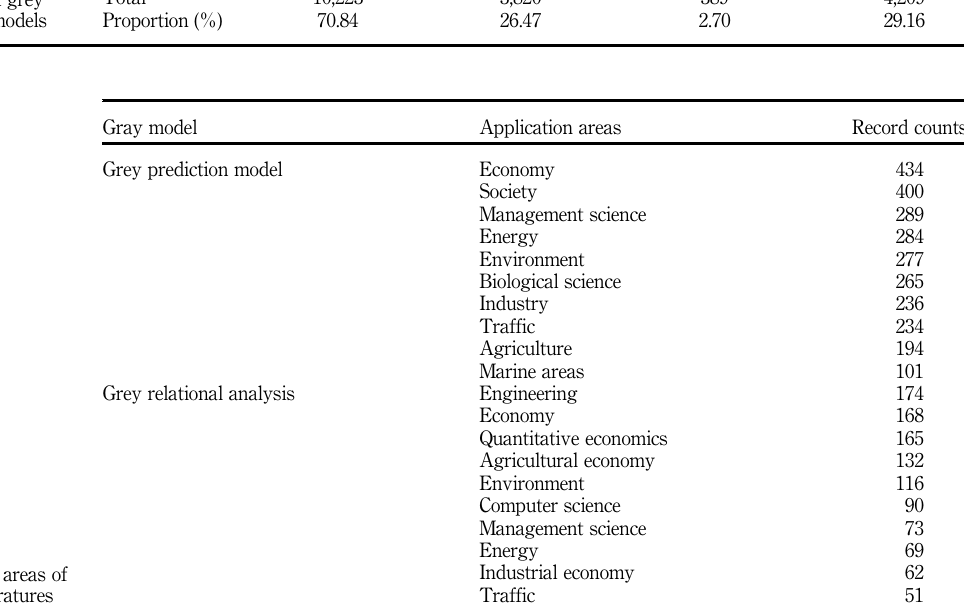
Table II. Application areas of Chinese